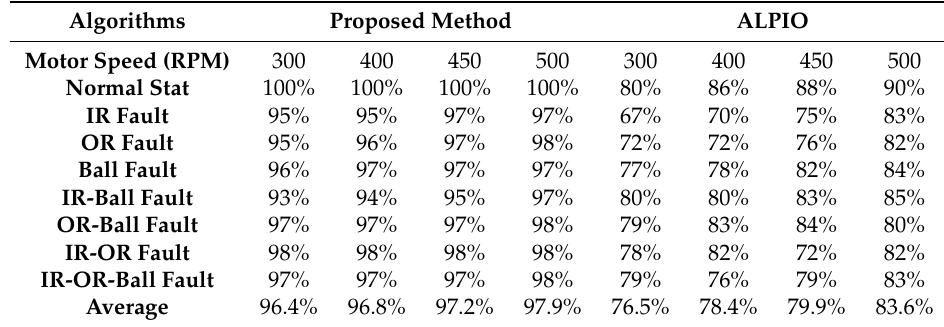
Table 8. Fault diagnosis results for various motor speeds using the proposed method and ALPIO (crack size = 3 mm).